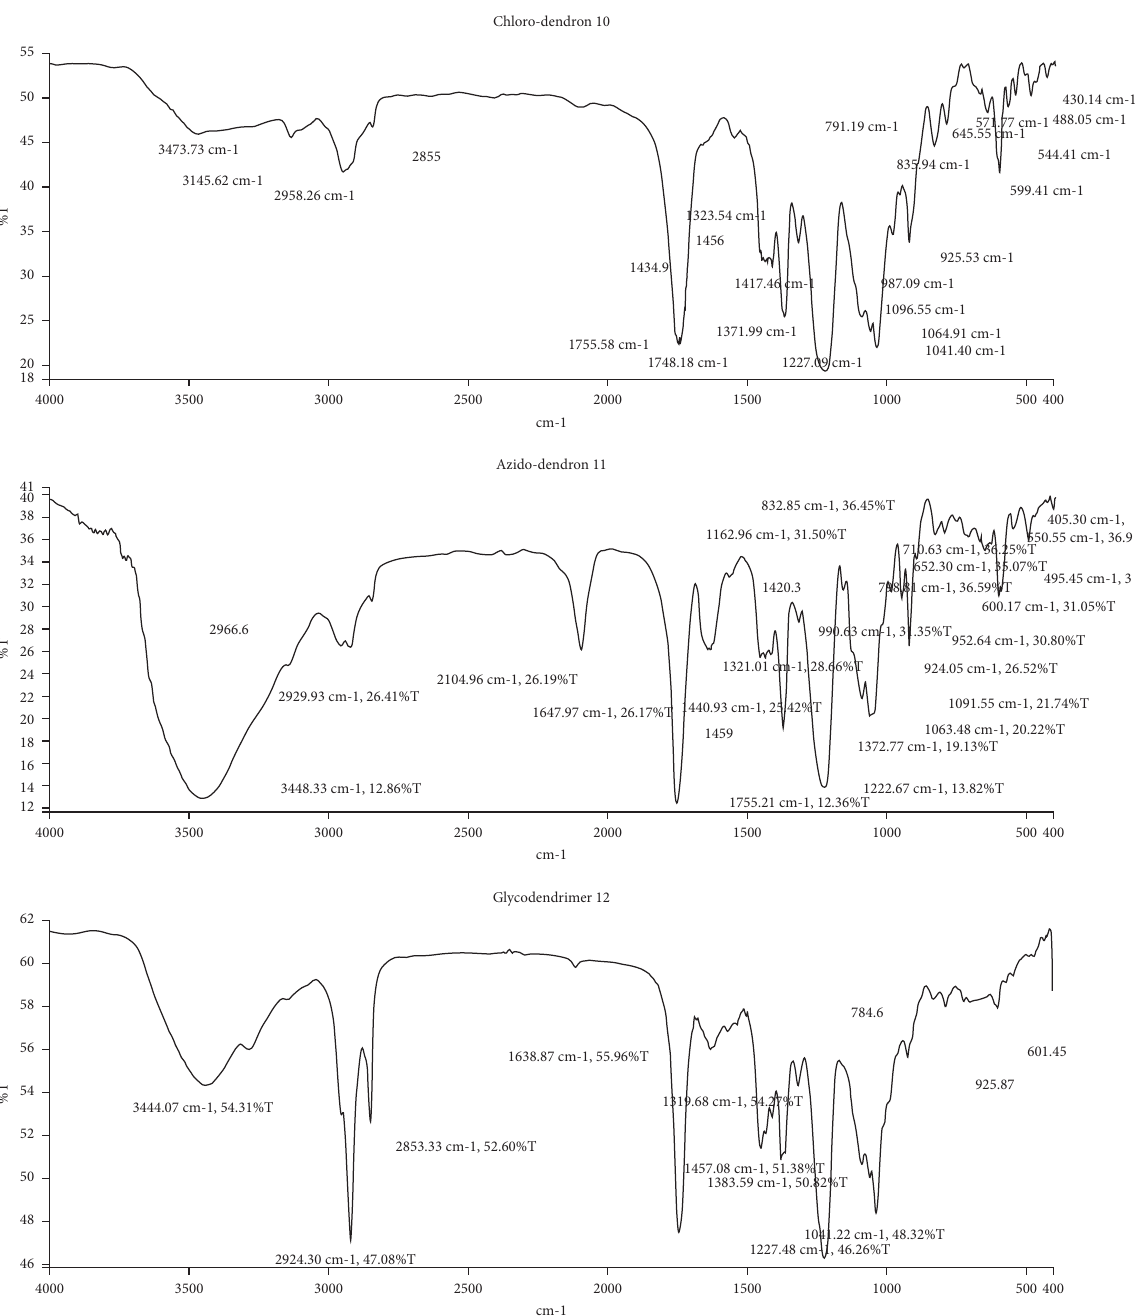
Figure 2: IR spectra of chlorine-functionalized dendritic wedge 10, azido-dendron 11, and chlorine-containing glycodendrimer